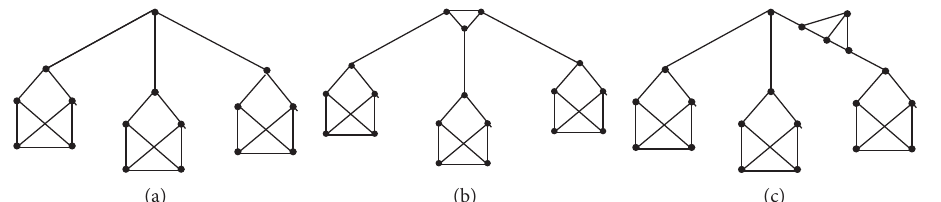
Figure 3: The extremal graph G of order n attaining the upper bound in Theorem 2, where (a) n ≡ 4, (b) n ≡ 0, and (c) n ≡ 2 (mod 6),